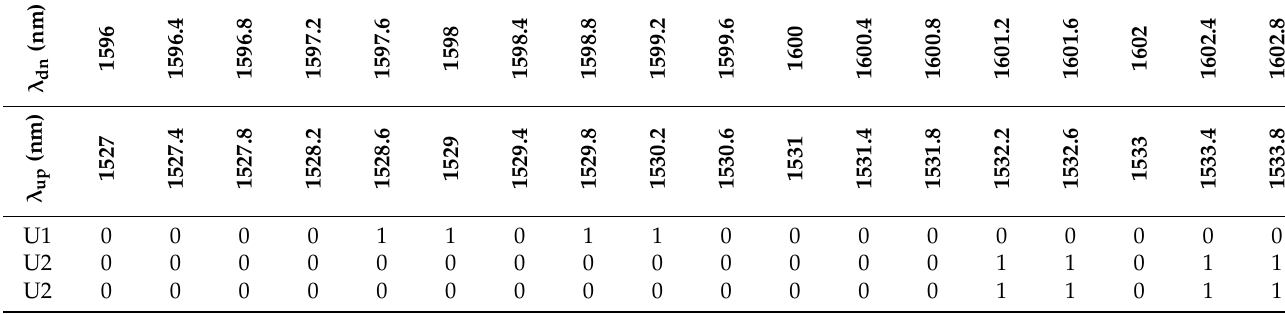
Table 1. MW-ZCC code design for two users for both downlink and uplink wavelengths [37].